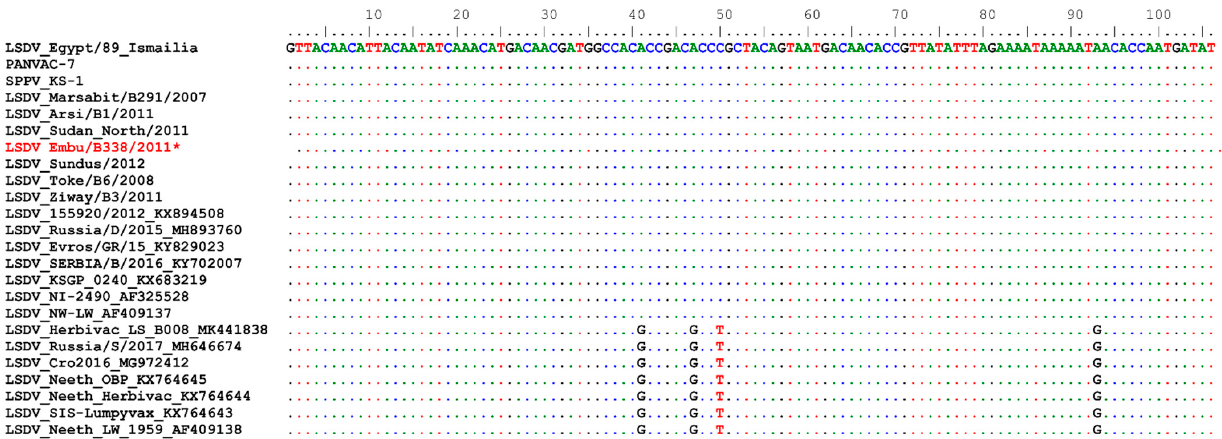
Figure 5. Multiple sequence alignments of the partial B22R gene sequences of LSDV Embu/B338/2011 (highlighted in red, with a star after the name) and 23 additional LSDVs retrieved from GenBank. The variable sites appear as letters, and identical nucleotides appear as